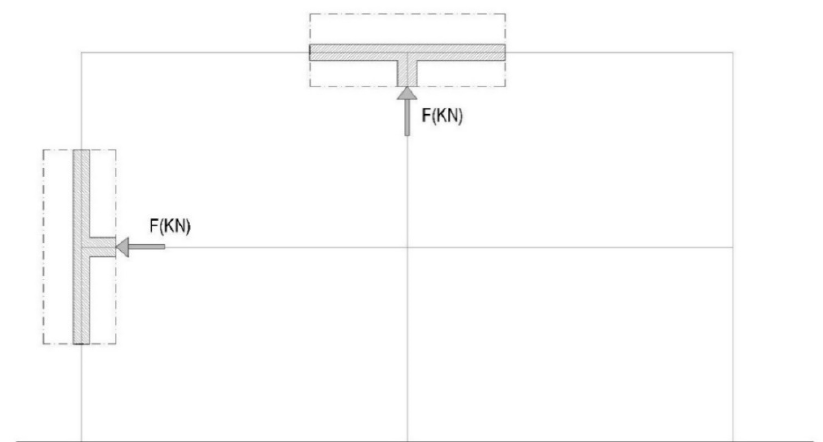
Figure 1. Detail of the T-joint in a conventional frame.